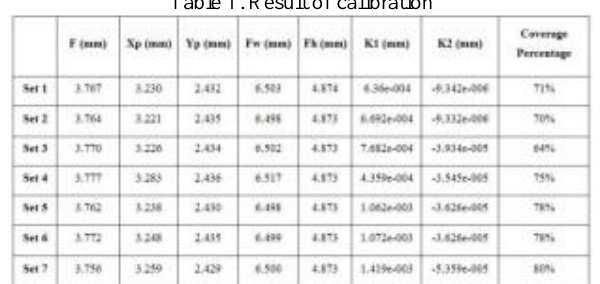
Table 1. Result of